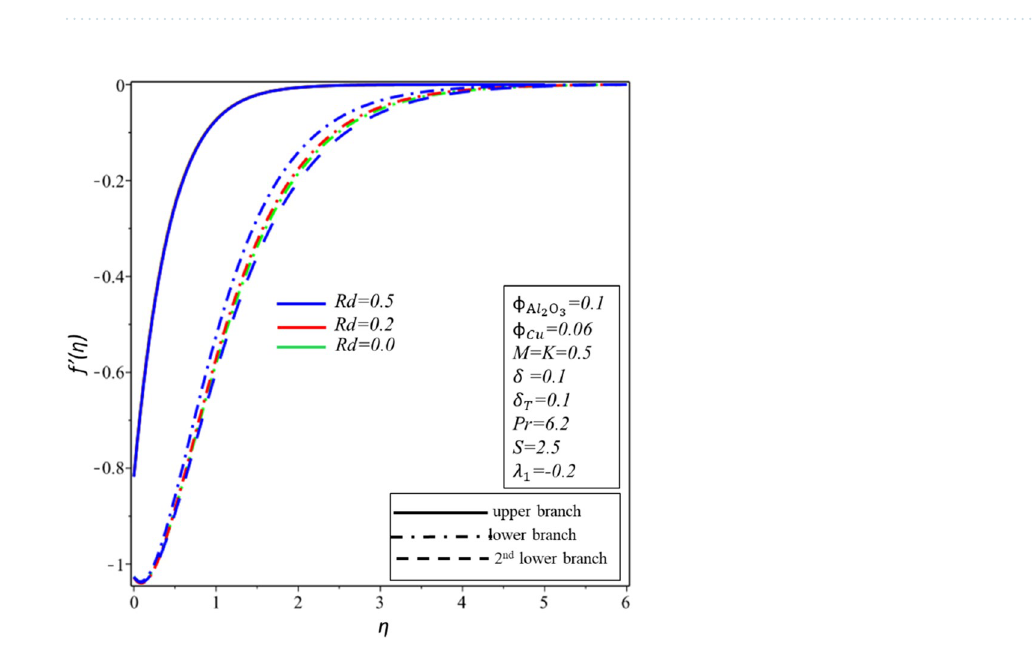
Figure 9. Behavior of